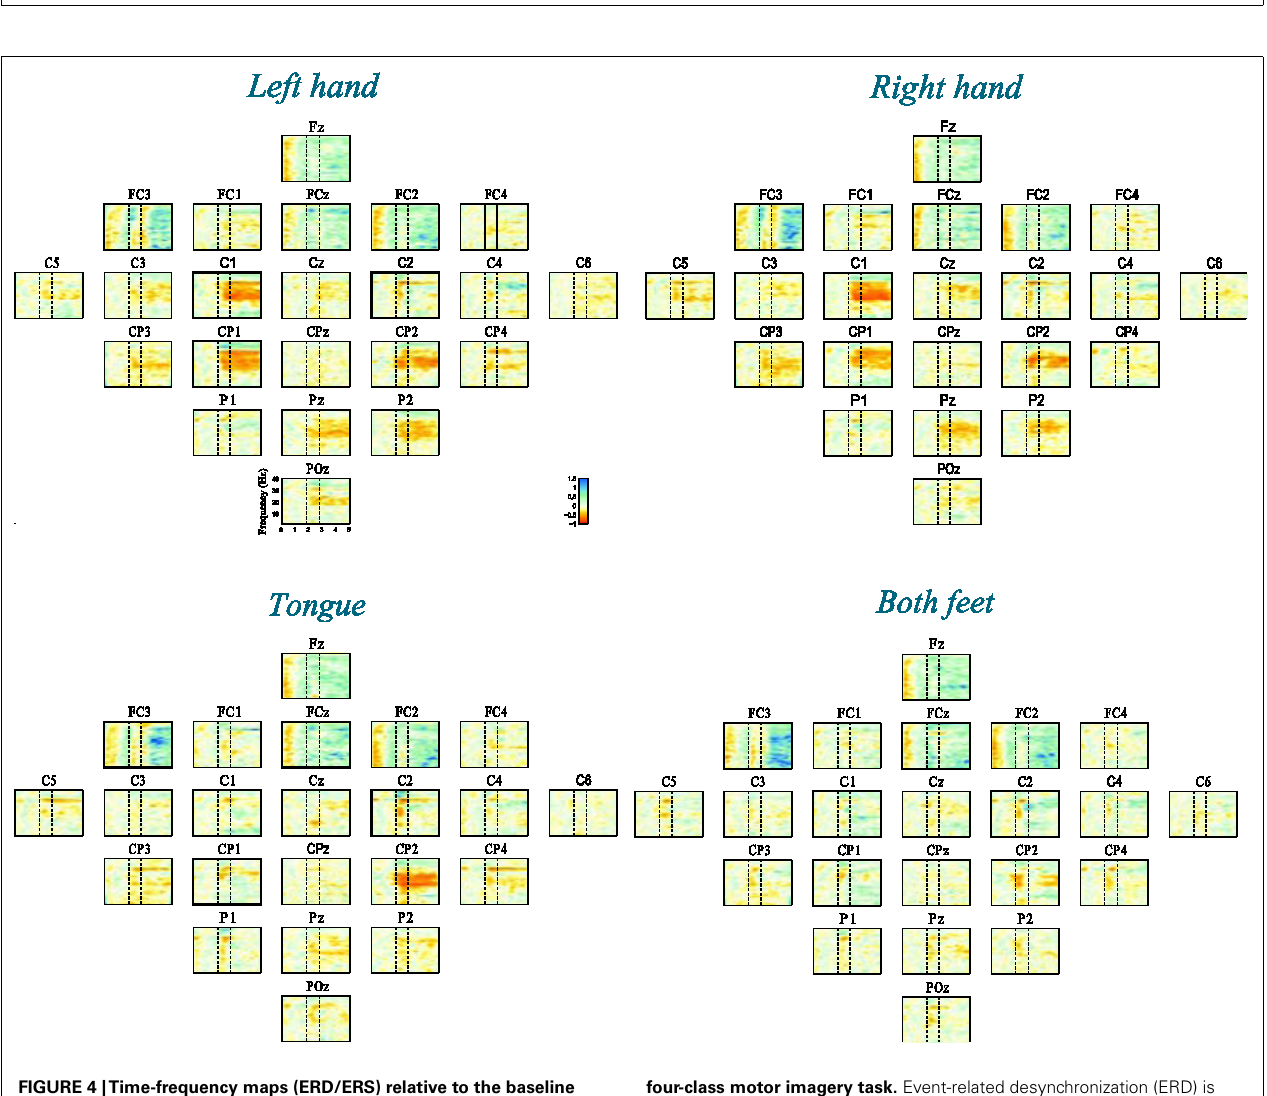
FIGURE 4 |Time-frequency maps (ERD/ERS) relative to the baseline recorded seconds before the event for all 22 EEG channels during